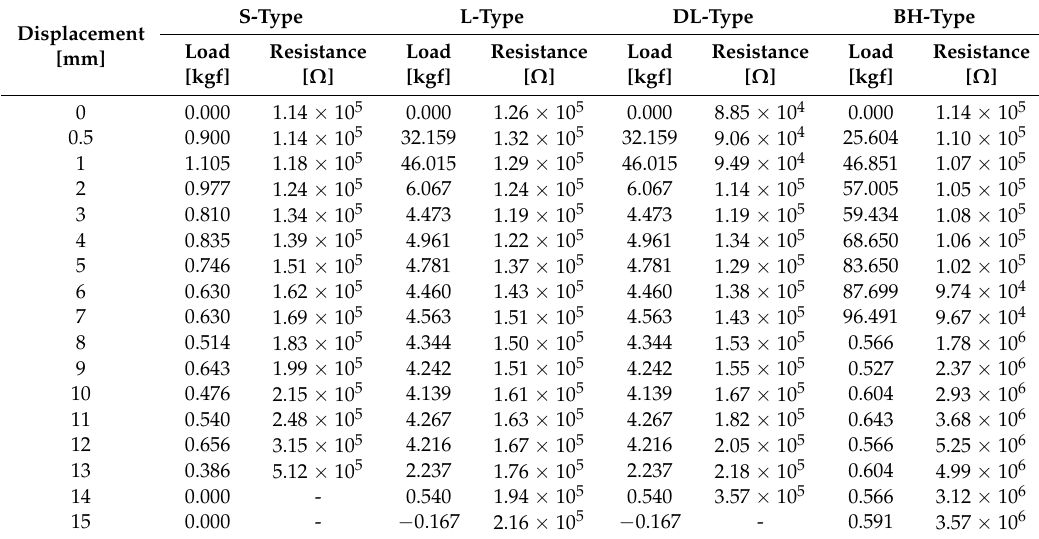
Table 1. Summarized mechanical–electrical information obtained during the SMA pullout tests involving the geometric modifications in Ni/Ti SMA fibers: S-type, L-type, DL-type, and